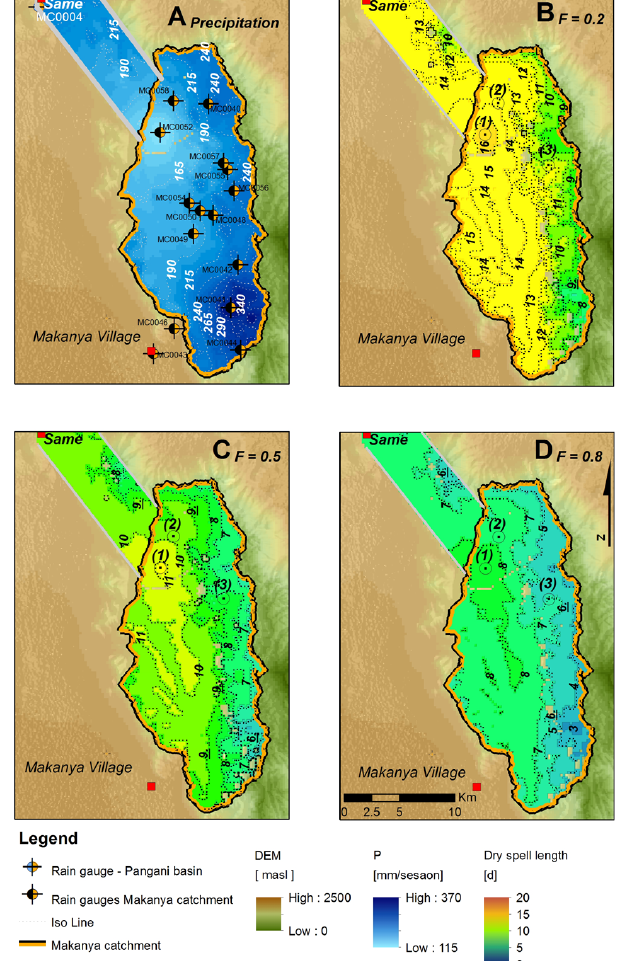
Fig. 4. (A) Ordinary co-kriging-derived synthetic rainfall map for rain season Masika. (B–D) Map with dry spell length for fixed prob- abilities of non-exceedance: p ne = 80%, 50% and 20%. Numbers in brackets indicate locations for which the critical dry spell was